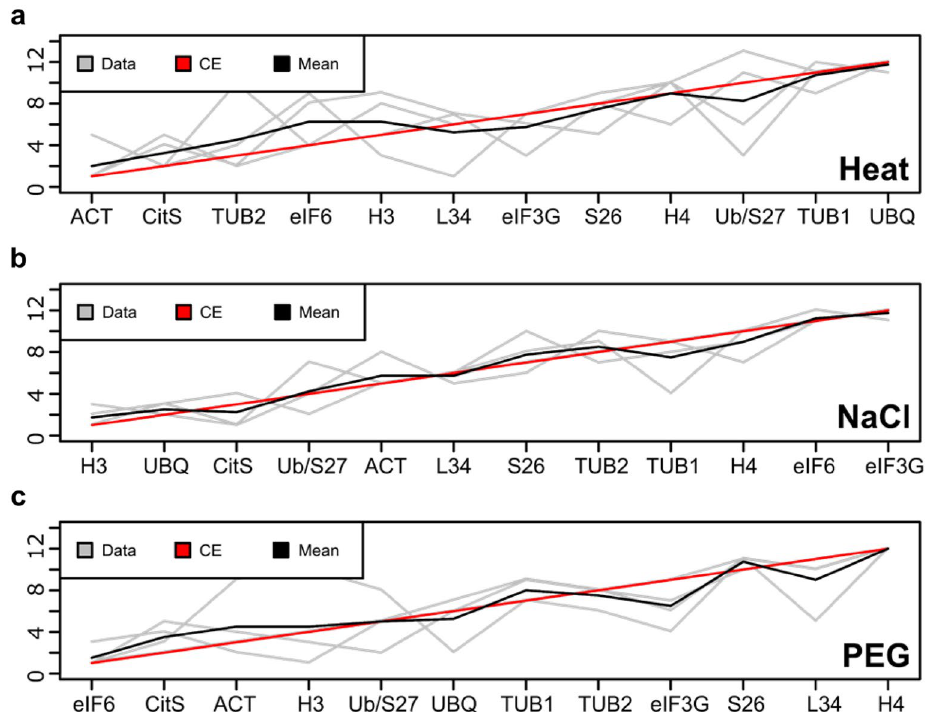
Figure 3. Rank aggregation of candidate reference genes for each algorithm in the three stress conditions, ( a ) heat shock, ( b ) salt stress and ( c ) PEG-induced dehydration. Analysis was performed by RankAggreg package in R software. Grey lines corresponding to ranking by NormFinder, GeNorm, dCq and BestKeeper, black line represents the mean rank of each methods and red line the results of best rank combination determined by the Cross-Entropy algorithm